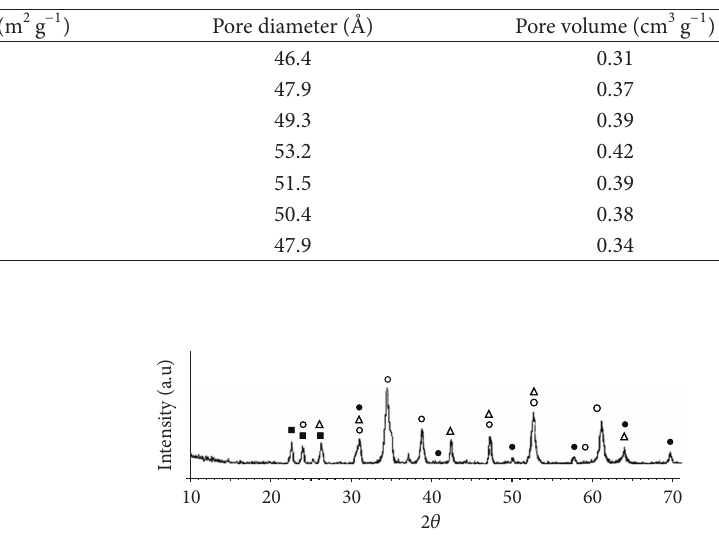
T 3: N adsorption-desorption measurements of iron-manganese catalyst treated with H 2